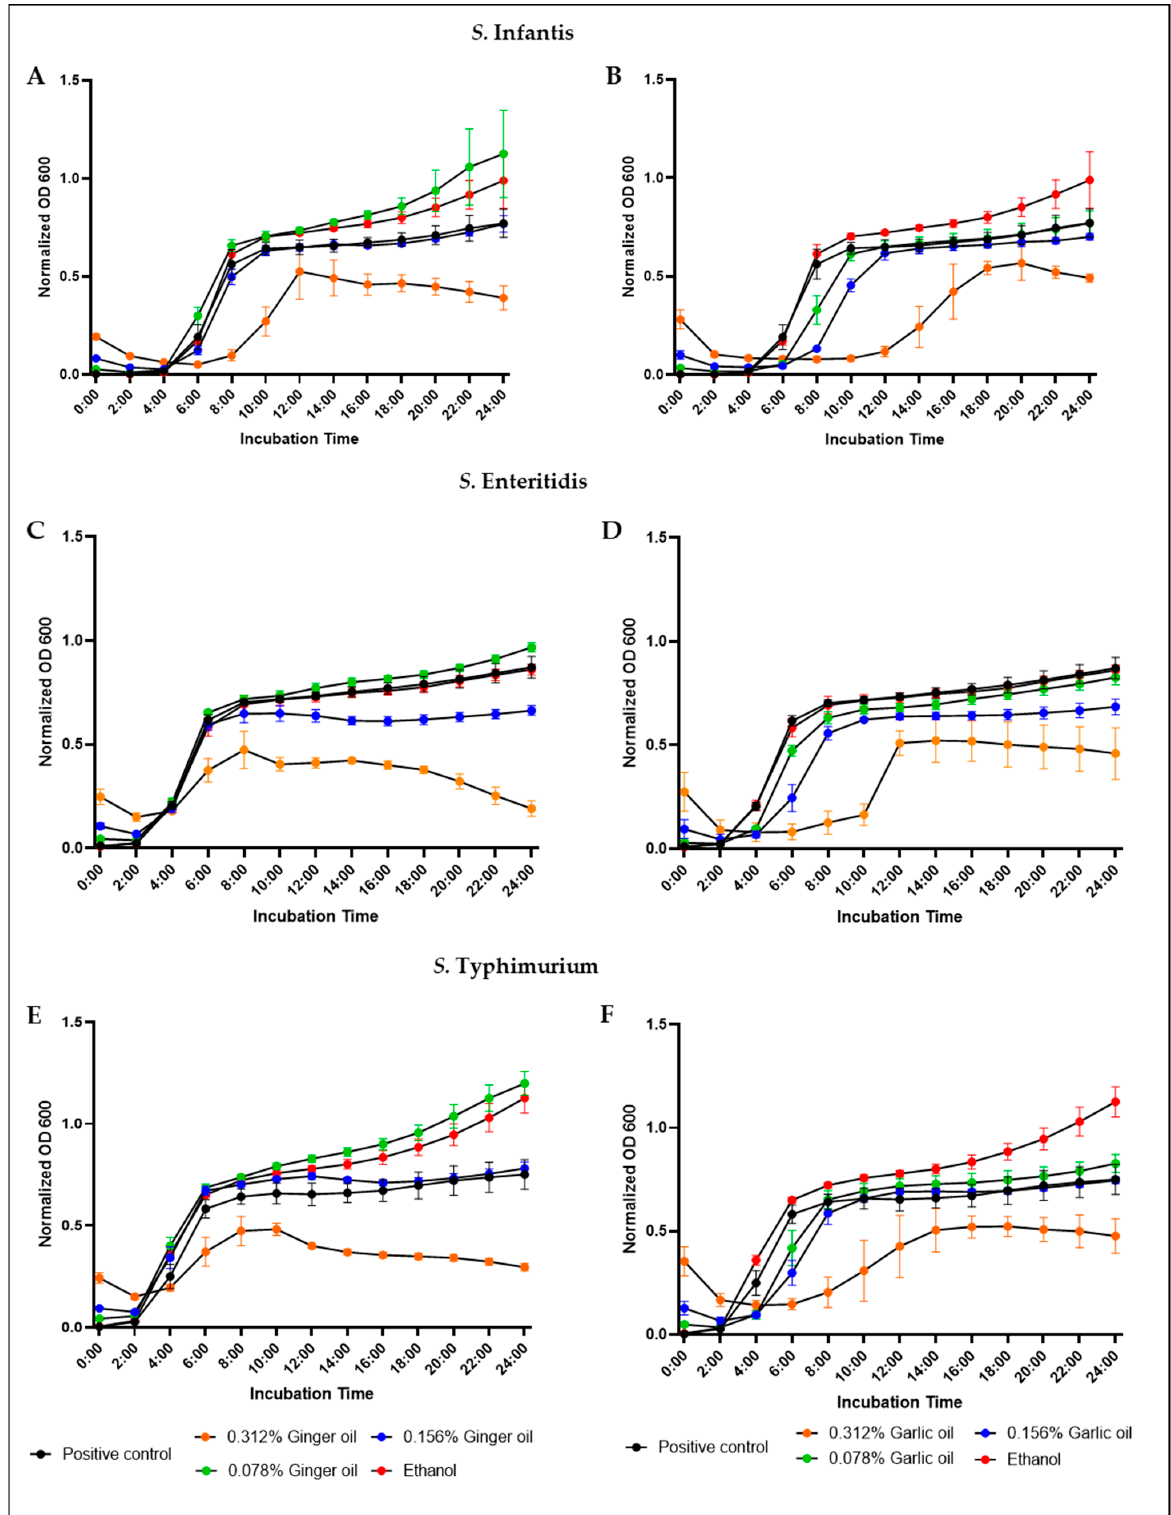
Figure 2. Determination of SIC of ethanol, ginger oil, and garlic oil against S. Infantis ( A , B ), S. Enteritidis ( C , D ), and S. Typhimurium ( E , F ) in a microtiter plate. Results are averages of two independent experiments, each containing duplicate samples (mean and STD). Experiments using ginger oil are shown in the first column, and garlic oil in the second column.